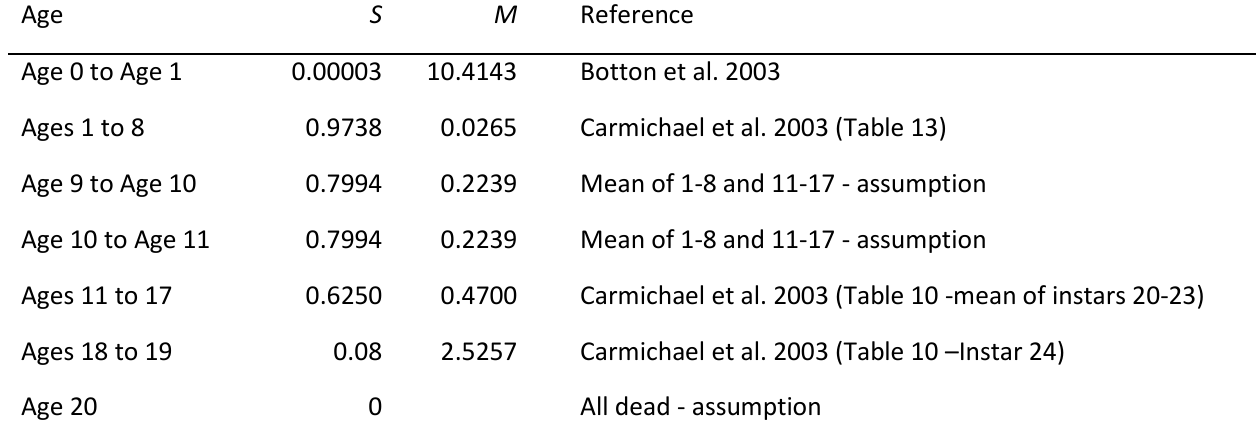
Table 7. Instantaneous natural mortality rate (M) schedule.